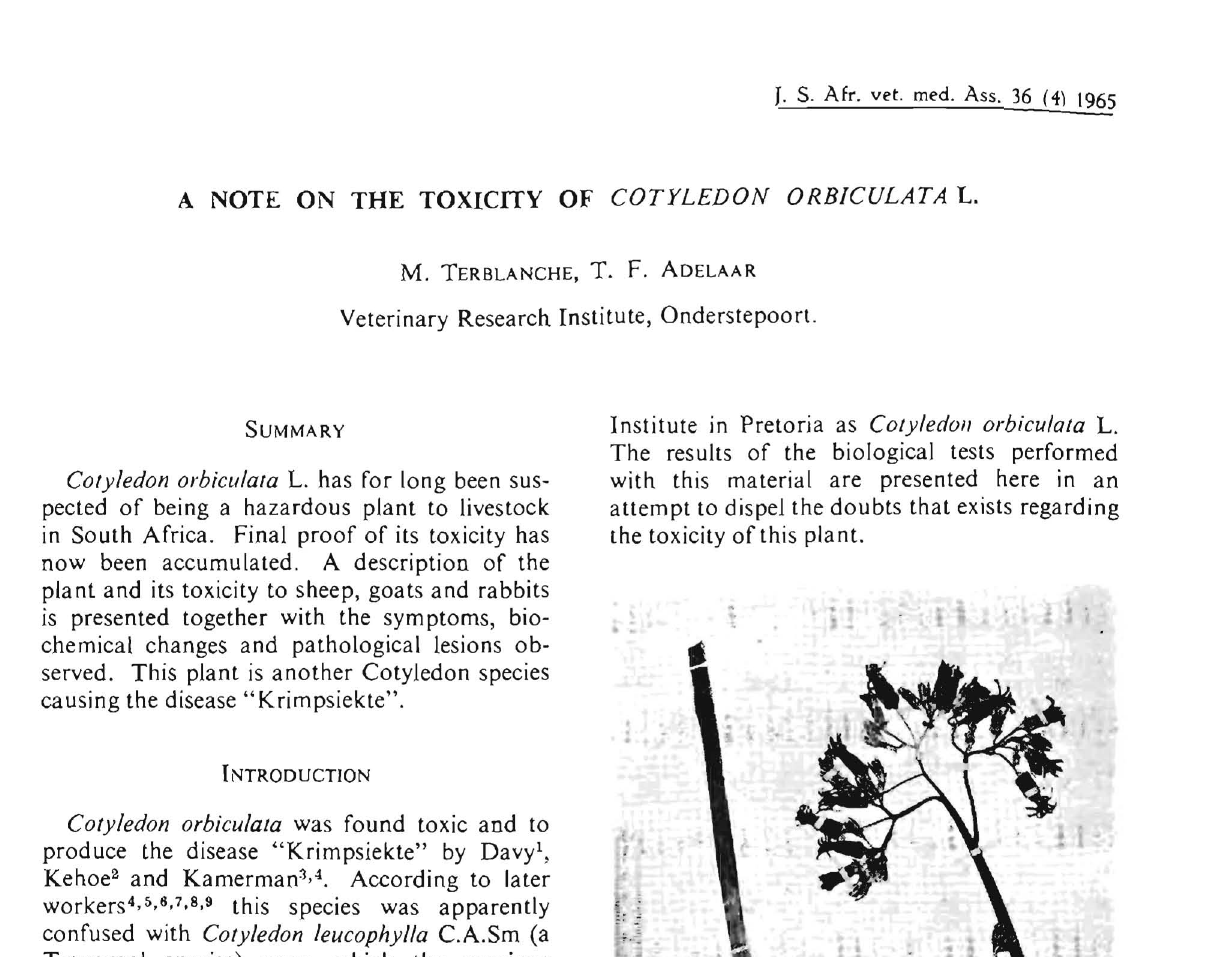
Fig. 1 Cotyledon